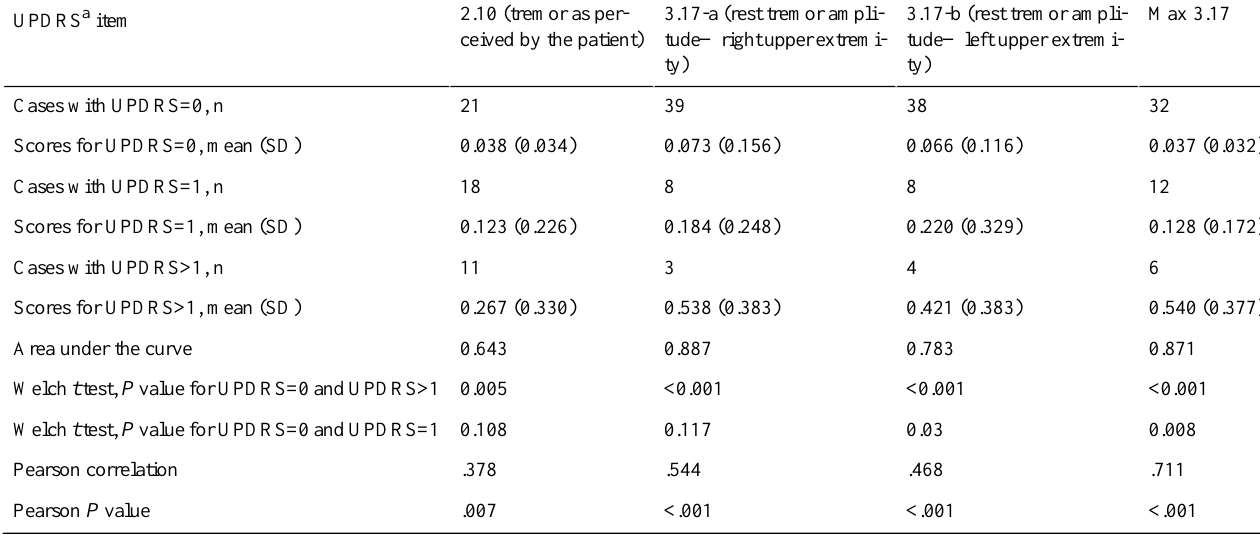
Table 6. Correlations between Unified Parkinson’s Disease Rating Scale tremor-related items and our tremor method